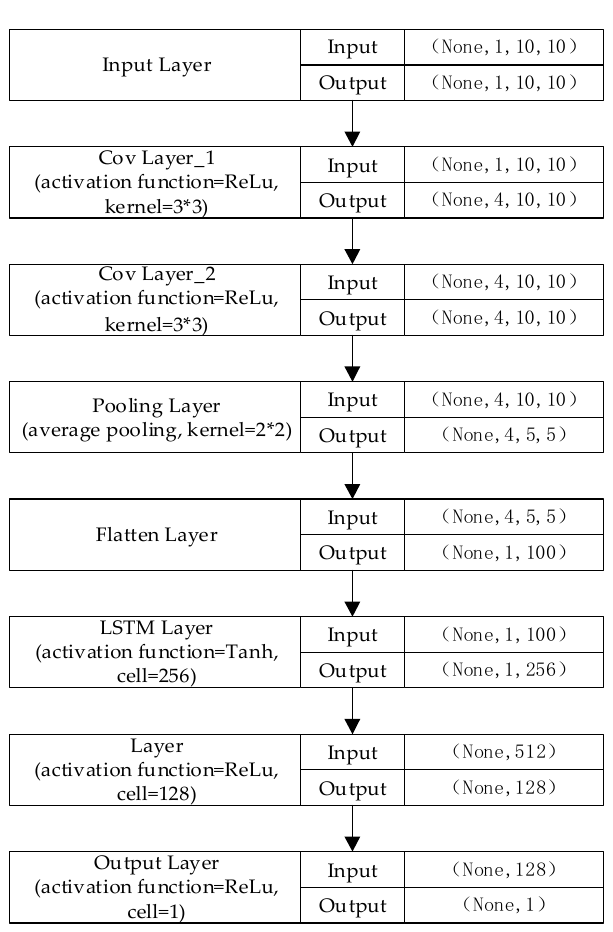
Figure A6. CNN- LSTM model architecture.